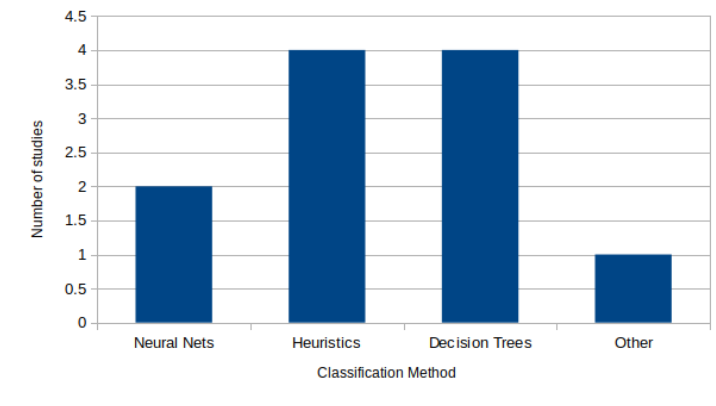
Figure 10. Classification methods used by the reviewed